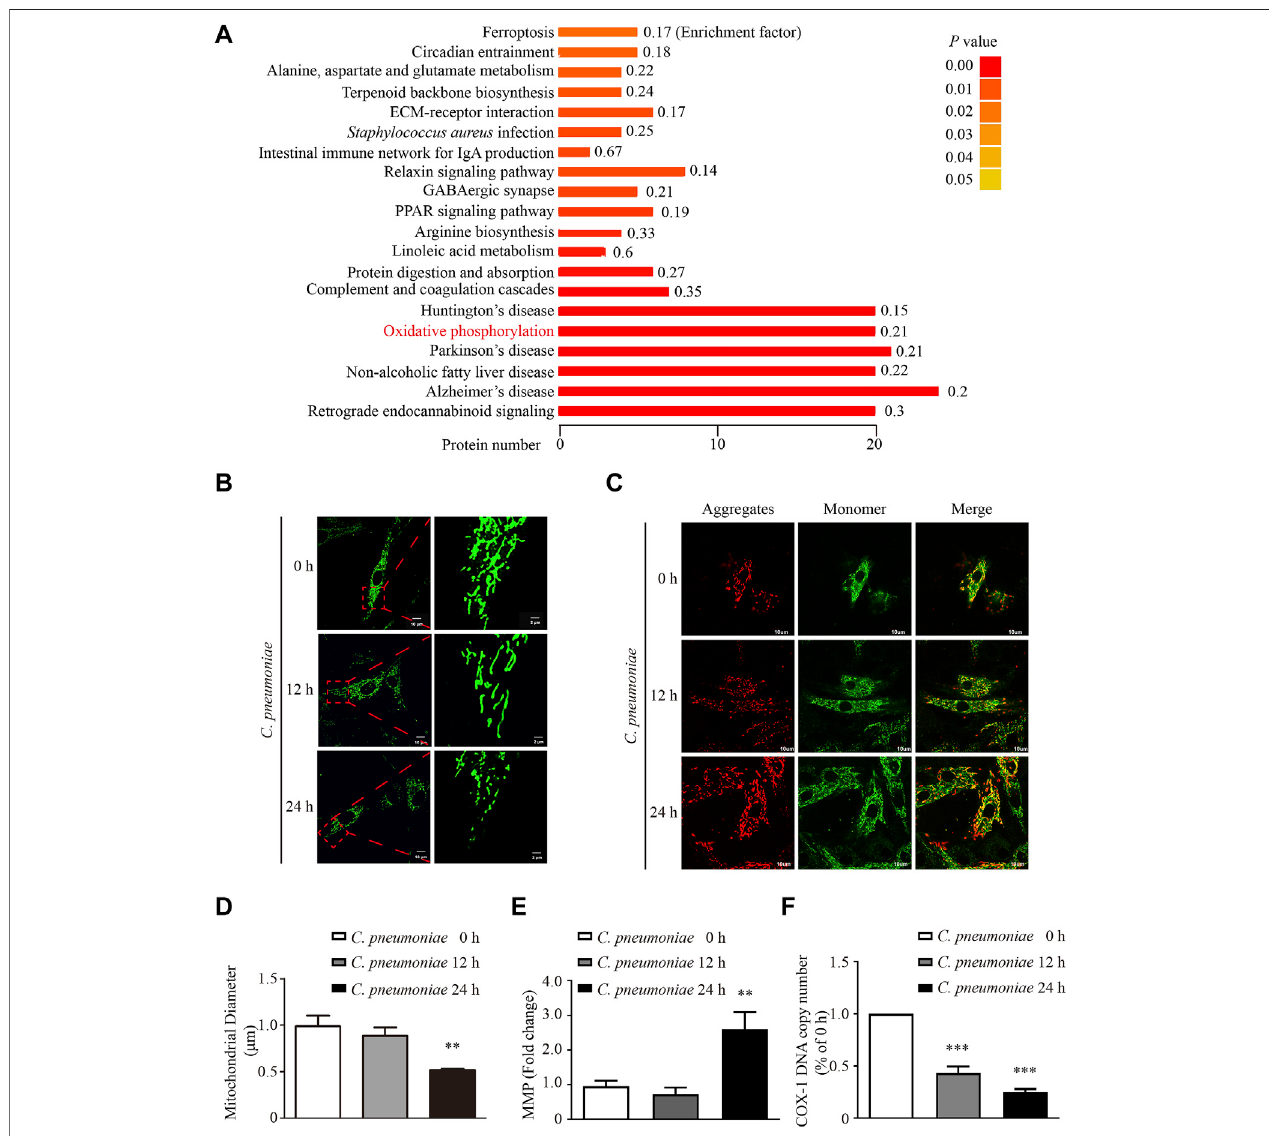
FIGURE 1 | C. pneumoniae infection induces mitochondrial dysfunction in VSMCs. VSMCs were infected with C. pneumoniae (5 × 10 5 IFU). (A) Differentially expressedproteinsinKEGGpathwayinVSMCsafter C.pneumoniae infection. (B) Mito-TrackerGreenstainingshowedmitochondrialmorphologyinVSMCs.Scalebar: 10 μ M (Left), 2 μ M (Right). (C) Mitochondrial membrane potential (MMP) is indicated by JC-1. Scale bar: 10 μ M. (D) Quantitative analyses of mitochondrial length in VSMCs. ** p < 0.01, compared with C. pneumoniae infection 0 h group, as analyzed by One-Way ANOVA. (E) Quantitative analyses of mitochondrial membrane potential (MMP). JC-1 monomer yields green fl uorescence due to low mitochondrial membrane potential; JC-1 aggregates yielding a red fl uorescence due to high mitochondrial membrane potential. ** p < 0.01, compared with C. pneumoniae infection 0 h group, as analyzed by Student ’ s t -test. (F) COX-1 DNA copy number in different groups. *** p < 0.001, compared with C. pneumoniae infection 0 h group, as analyzed by One-Way ANOVA.